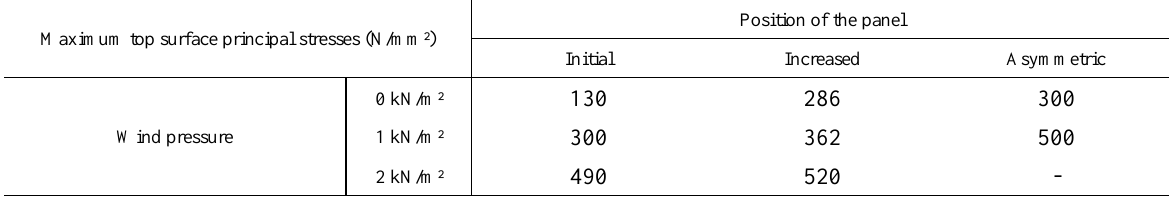
Table 3: Maximum top surface principal stresses in N/mm² according to wind pressure and position of the panel. Glass plate characteristics: thickness: 1.1 mm / dimensions: 1750 x 3000 mm